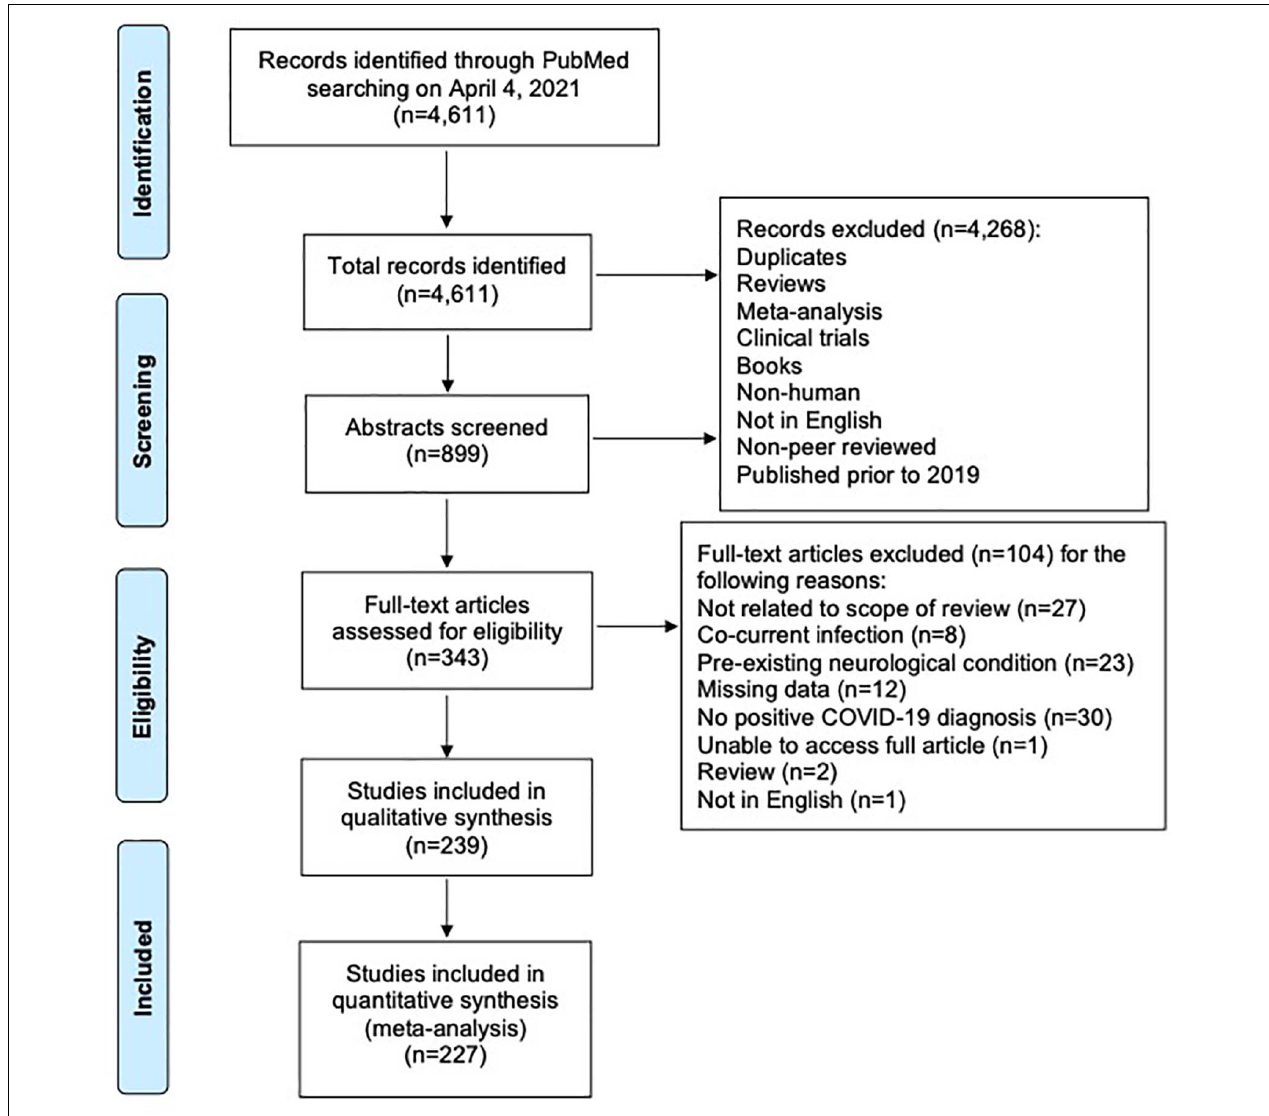
FIGURE 1 | PRISMA flow diagram of systematic literature search and screening for studies of COVID-19 patients with neurological